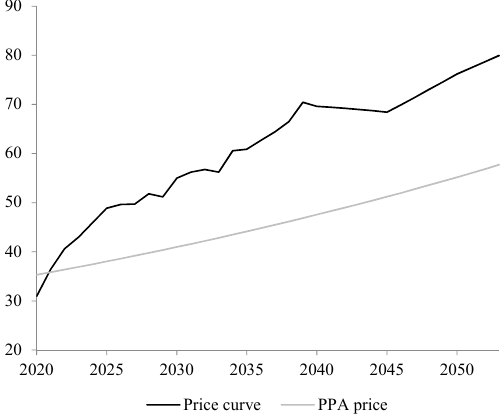
Figure 1. Expected solar price curve and PPA prices.